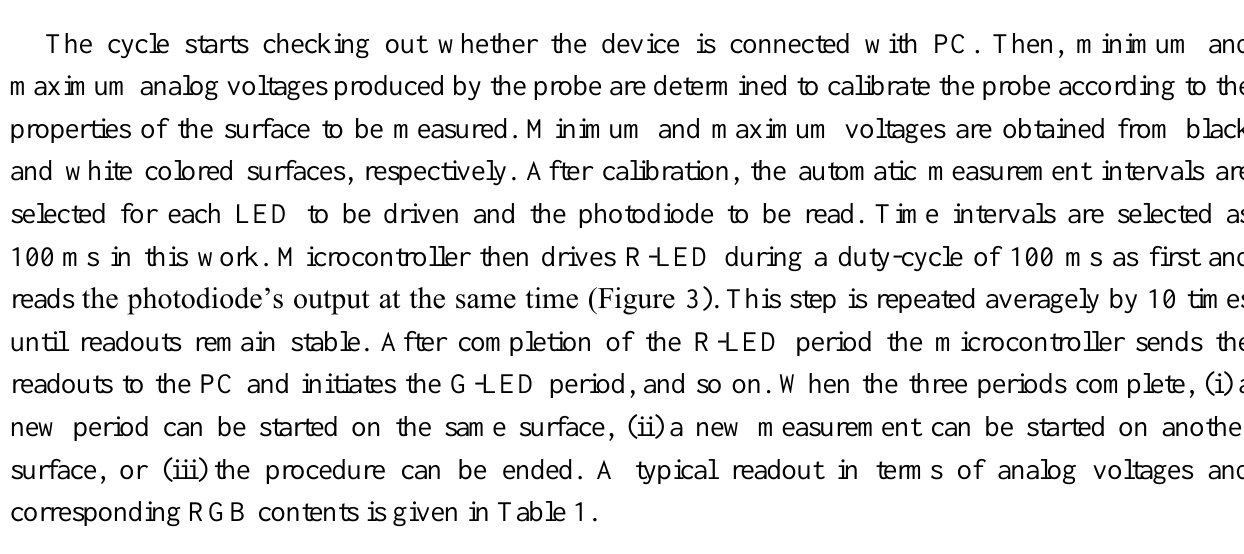
Figure 3. Switching of LEDs and the